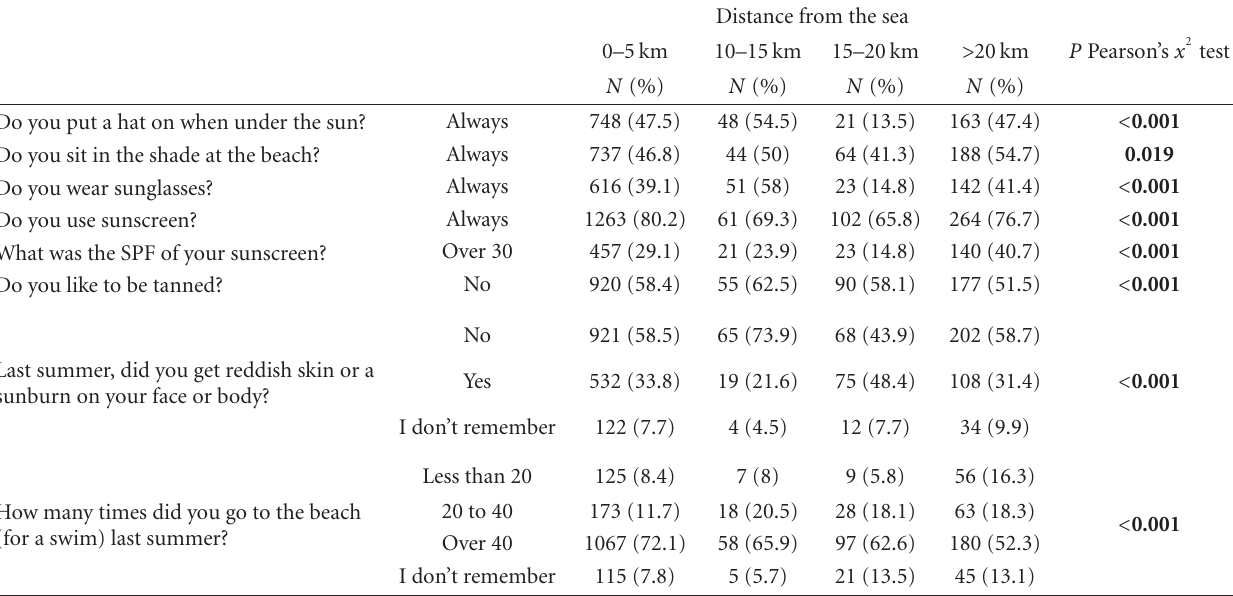
Table 2: Students’ behaviour according to place of residence.